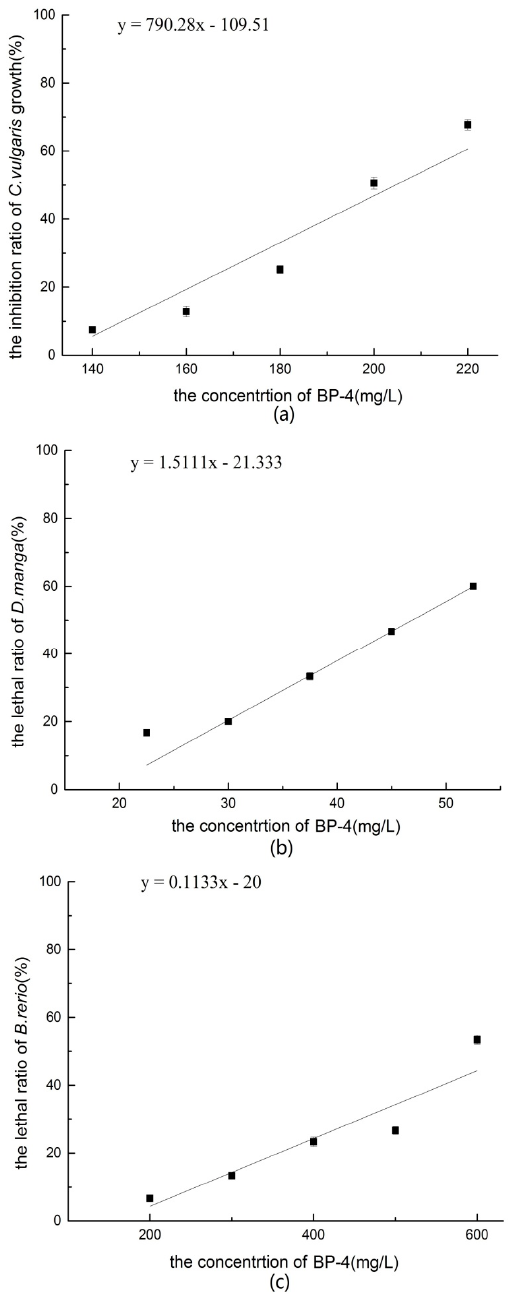
Figure 2. ( a ) The inhibition ratio of C. vulgaris growth of BP ‐ 4; ( b ) The lethal ratio of D. magna of BP ‐ 4; ( c ) The lethal ratio of B. rerio of BP ‐ 4.